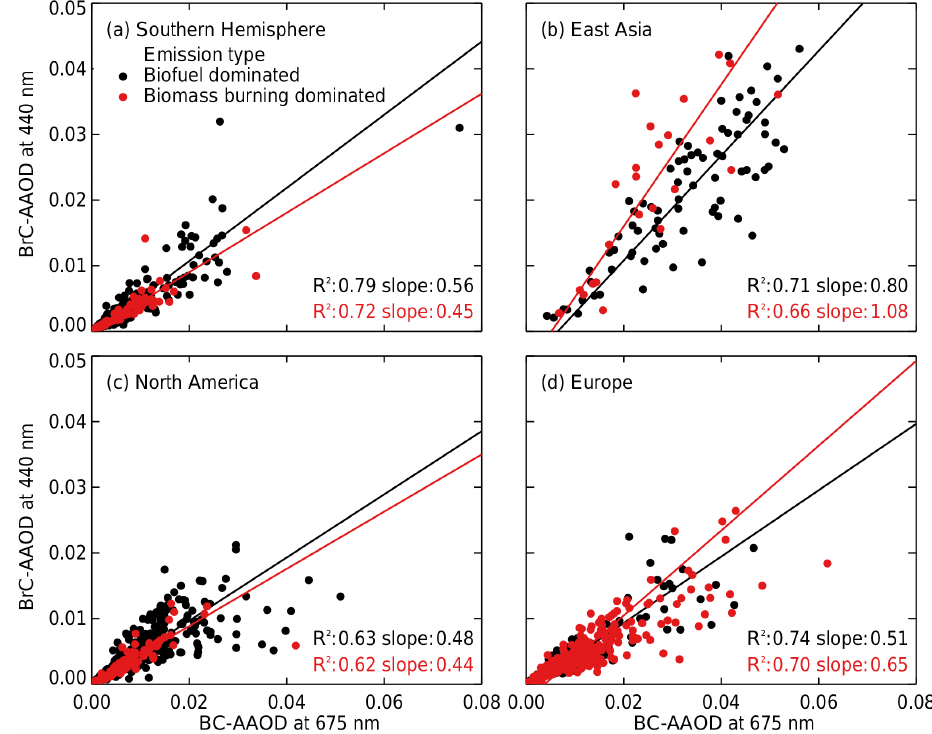
Figure 5. The relationship between monthly mean derived AERONET BrC-AAOD at 440nm and BC-AAOD at 675nm at AERONET stations in (a) North America, (b) East Asia, (c) Europe, and (d) Southern Hemisphere for the years